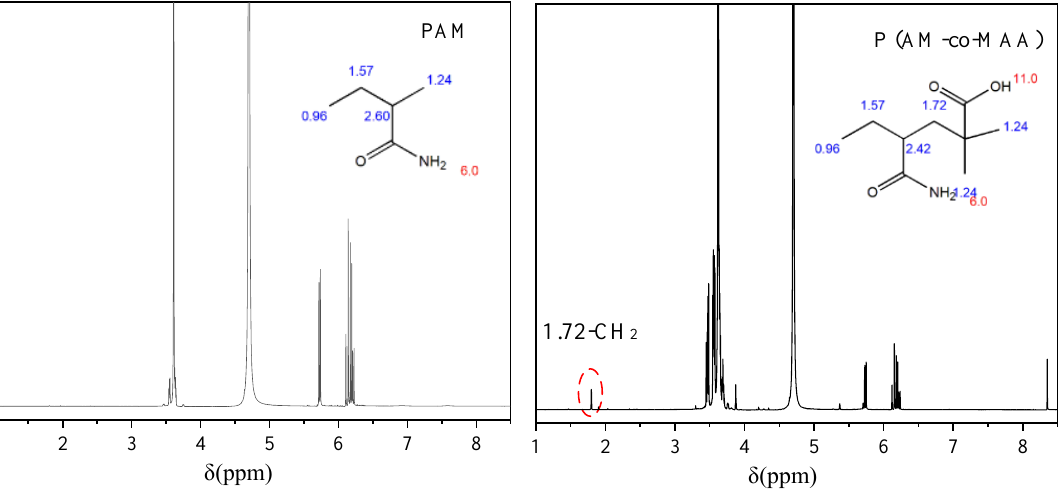
Figure 3. 1 H NMR spectra of PAM and P (AM-co-MAA).